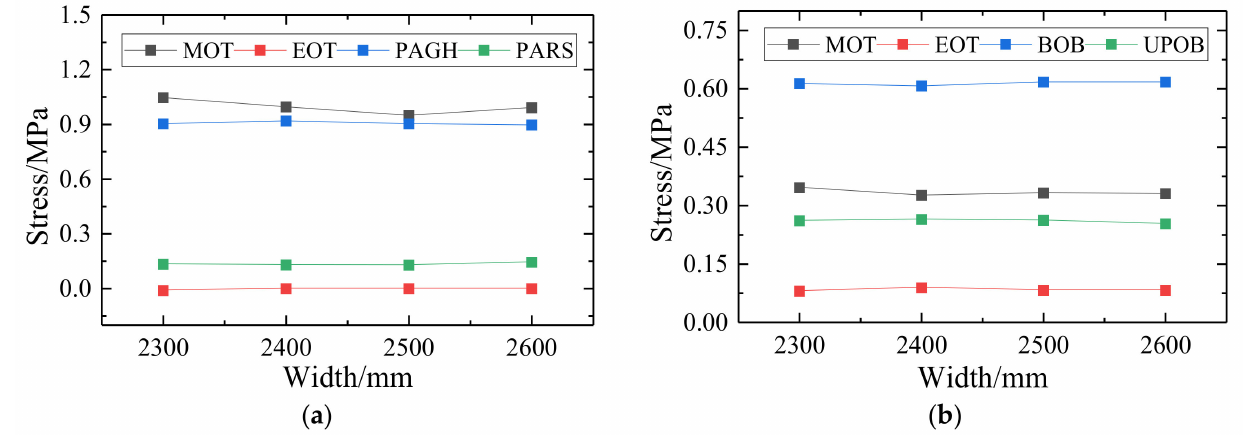
Figure 17. Maximum stress change curve of track structure under different width conditions: ( a ) Track slab; ( b ) Adjustment layer.